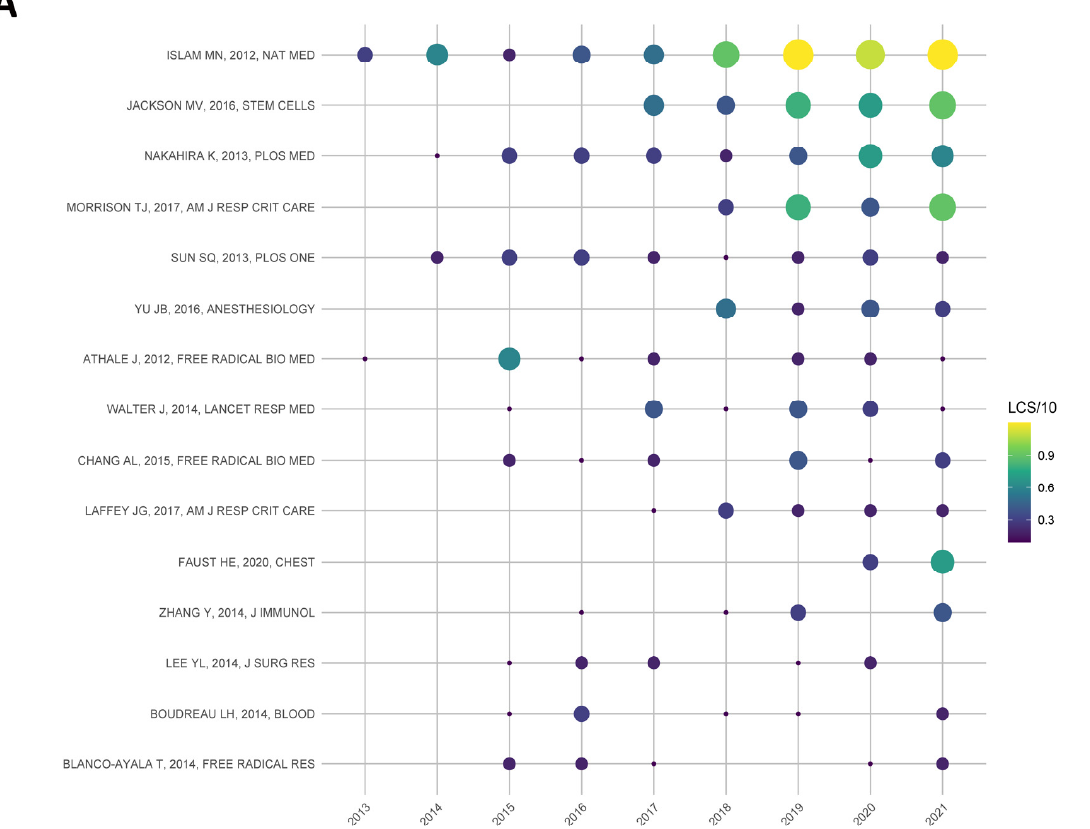
Figure 5. ( A ) The yearly number of local citations of papers with high local citation scores (LCS). Note: The size and colors of the circle represent the LCS of papers in that year. The larger the size and the more yellow the color of the circle, the higher the LCS is . ( B ) One paper cited by the other